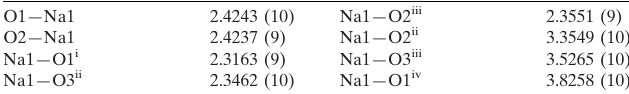
Selected bond lengths (A˚